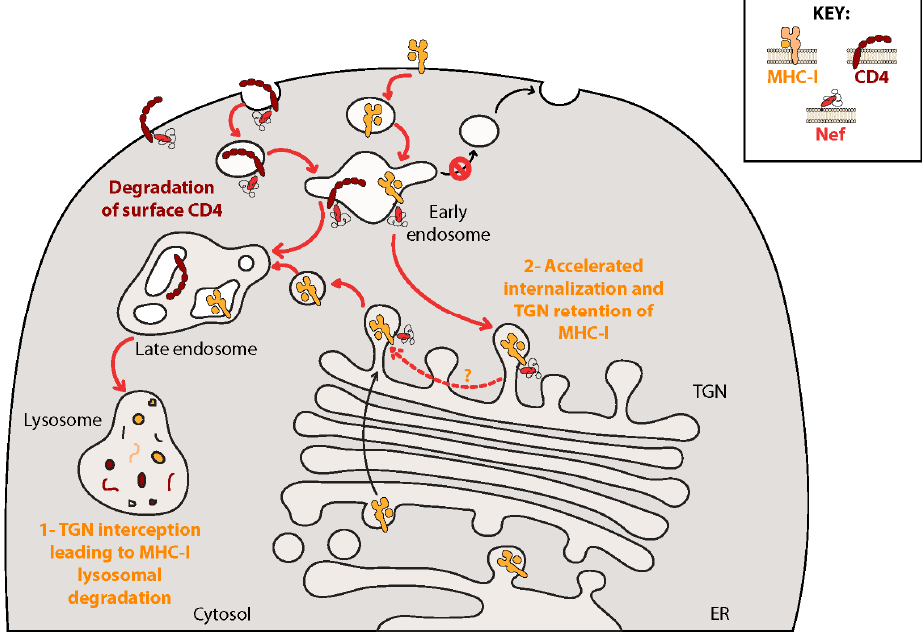
Figure 3. CD4 and major histocompatibility complex (MHC) ‐ I are downregulated by HIV ‐ 1 Nef protein. Nef downregulates CD4 by recruiting the AP ‐ 2 adaptor to link CD4 to clathrin ‐